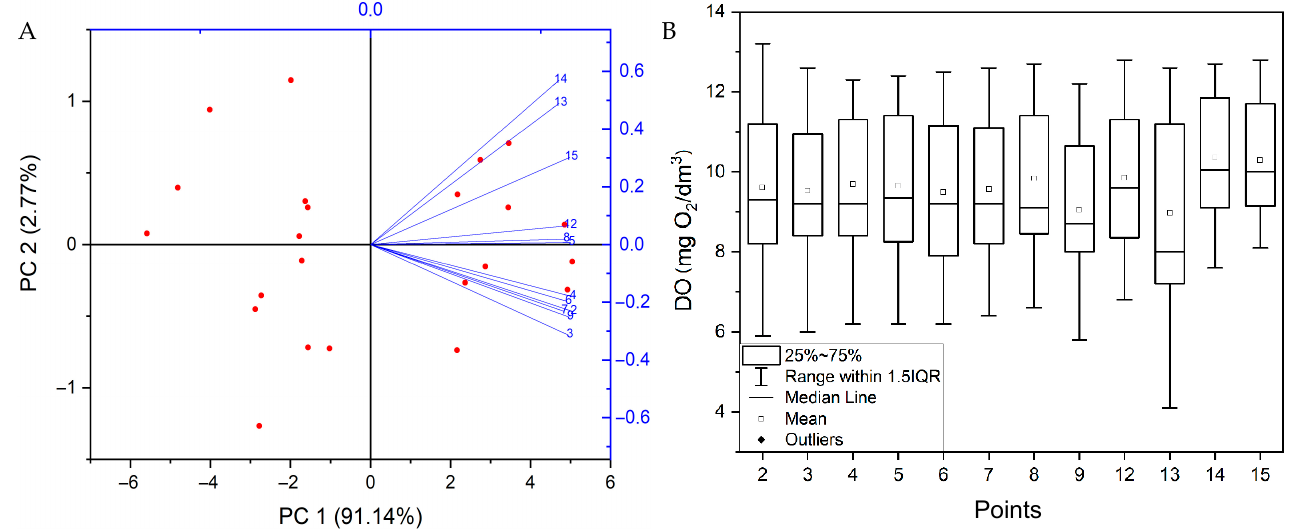
Figure 6. Statistical analyses for dissolved oxygen (DO): PCA ( 6A ) and boxplots ( 6B ; this research).